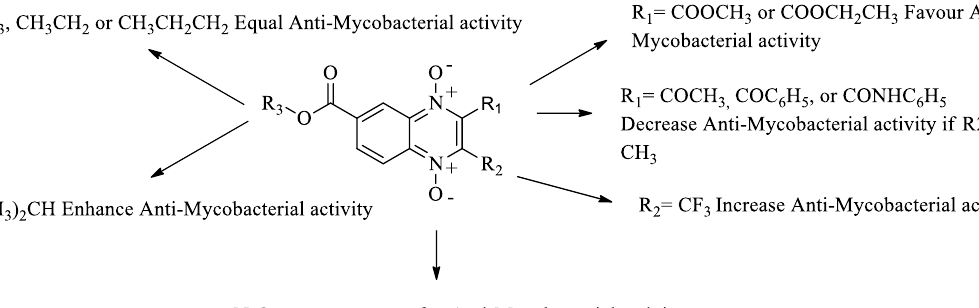
Figure 1. A structure-activity relationship analysis from esters of quinoxaline-7-carboxylate 1,4-di- N -oxide as antimycobacterial agents.